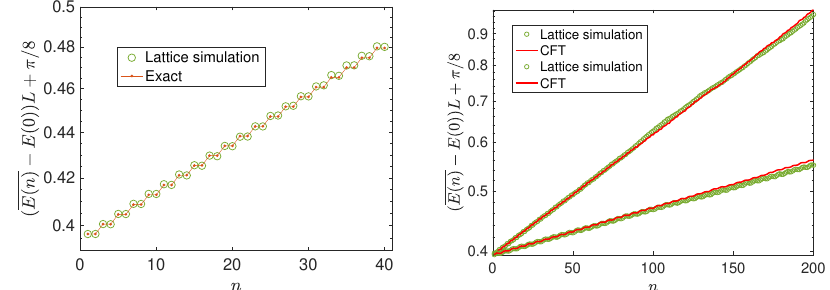
Figure 21: Comparison of lattice simulations and the analytical results / CFT results for the averaged entanglement entropy evolution at the type I exceptional point (left) and in the heating phase (right). The driving parameters are the same as Fig.